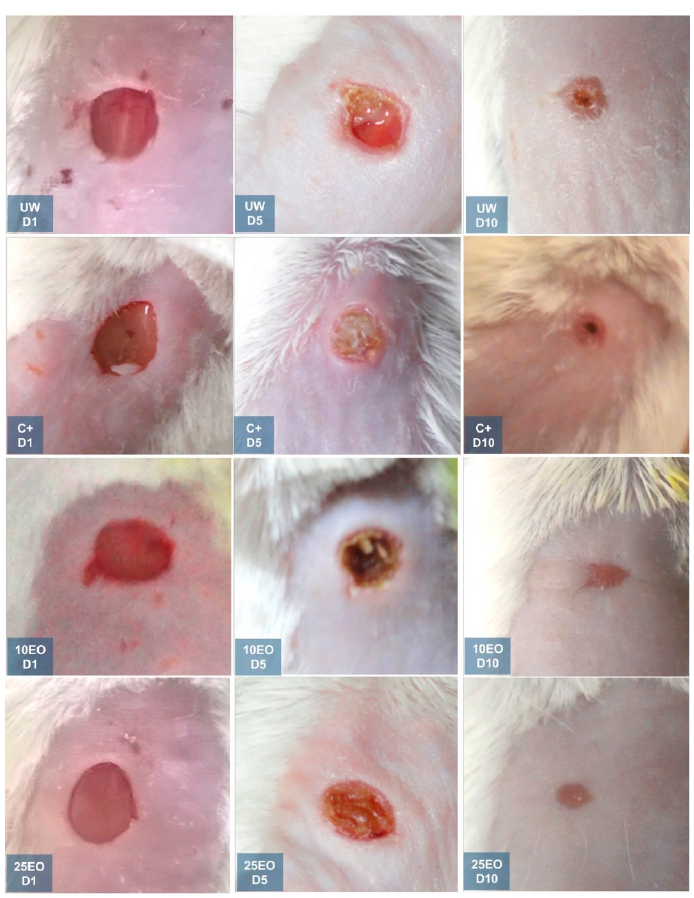
Figure 6. Macroscopic examination of wounds at the first, fifth, and tenth day of the experiment. UW, untreated wound. C + , positive control—Recoveron NC. 10EO, 10% essential oil. 25EO, 25% essential oil.